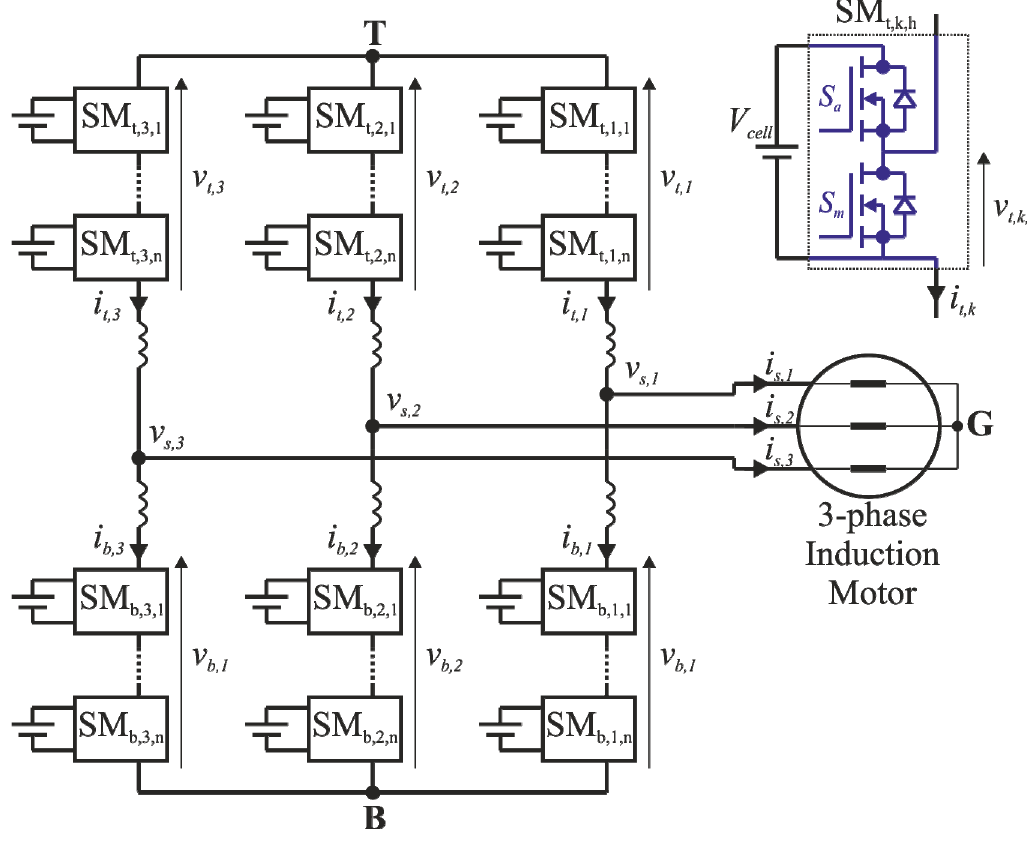
Figure 1. Modular multilevel converters (MMC) power topology.